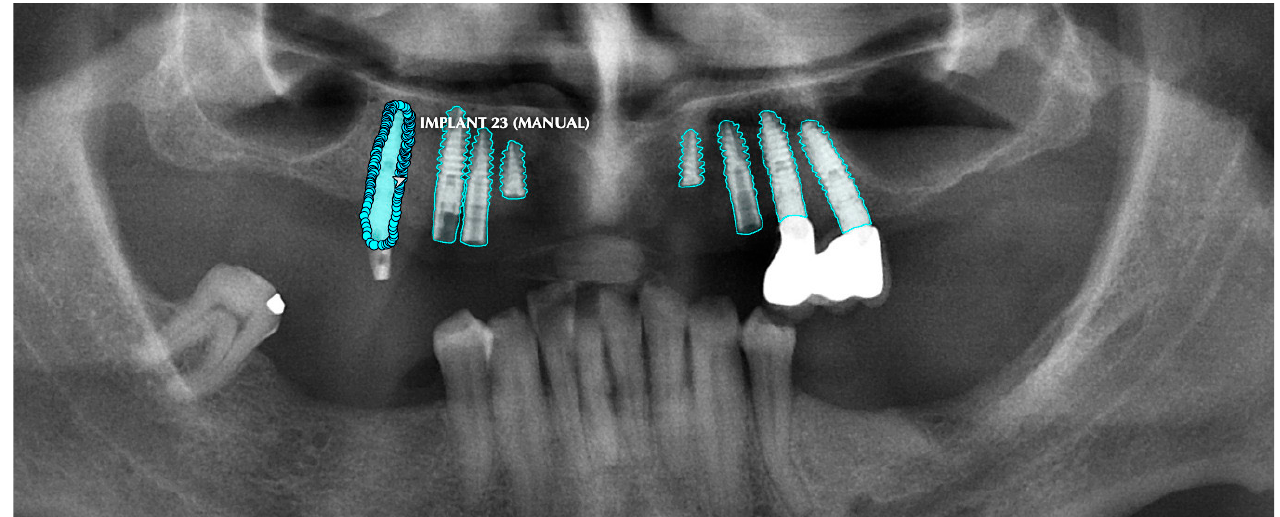
Figure 1. Manual segmentation process of the dental implants. Note the precision for the dental implant’s grove segmentation in order to achieve higher accuracy and DSC.